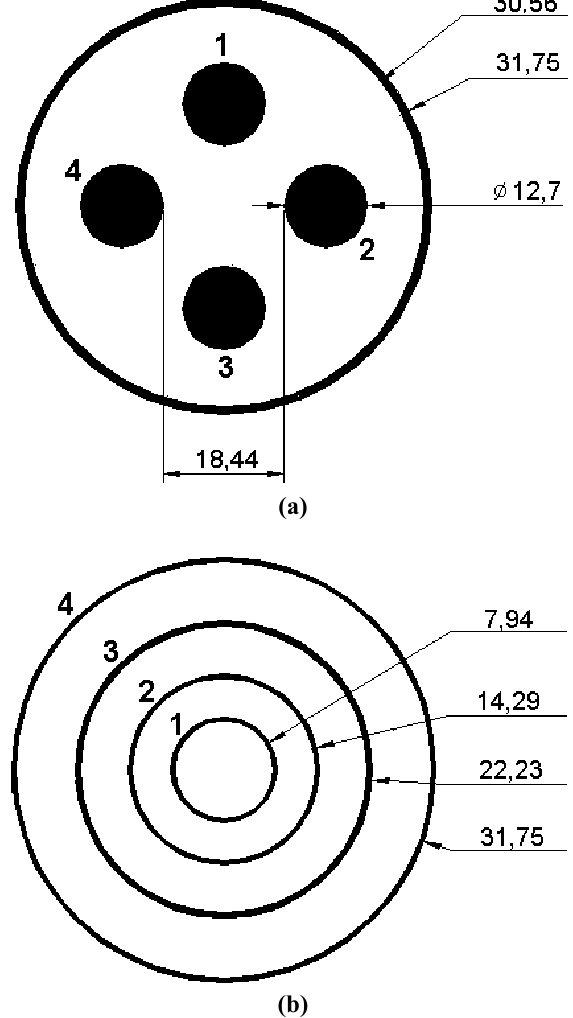
Figure 1: Electrode shapes. (a) Adjacent tetrapolar. (b) Axial concentric tetrapolar. The arrows show the dimension in